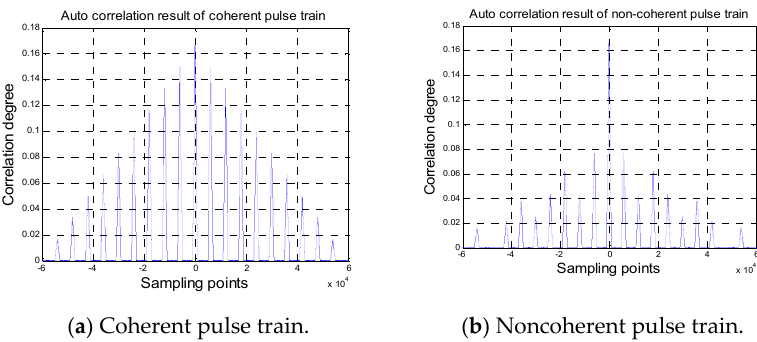
Figure 2. Autocorrelation result of coherent and noncoherent pulse trains; signal type is continuous wave (CW).